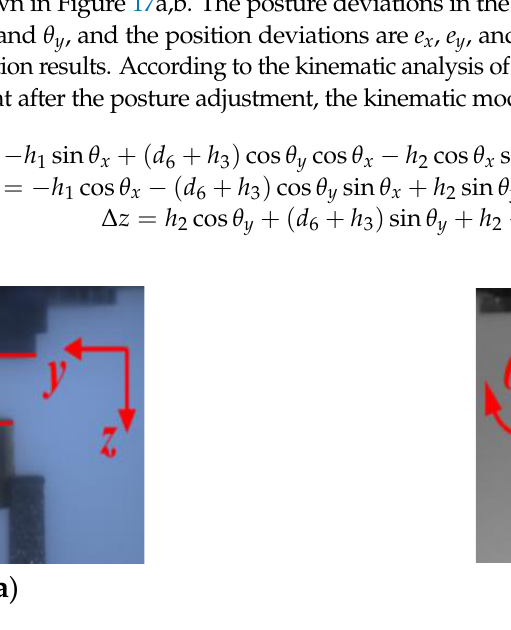
Figure 17. Size calibration of CCD. ( a ) Draw lines on the sleeve to mark its frontal posture; ( b ) Draw lines to sleeve to mark its left posture.